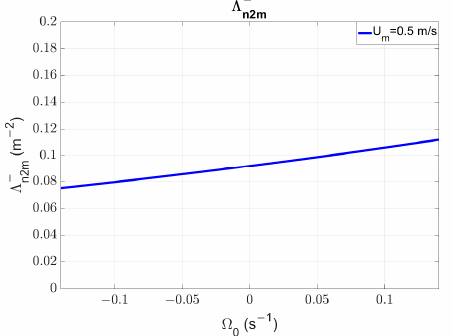
Figure 13. Λ (surface elevation coefficient) of the n2m-negative interaction component as functions of vorticity on a stronger following current where U m = 0.5 ( m/s ) .